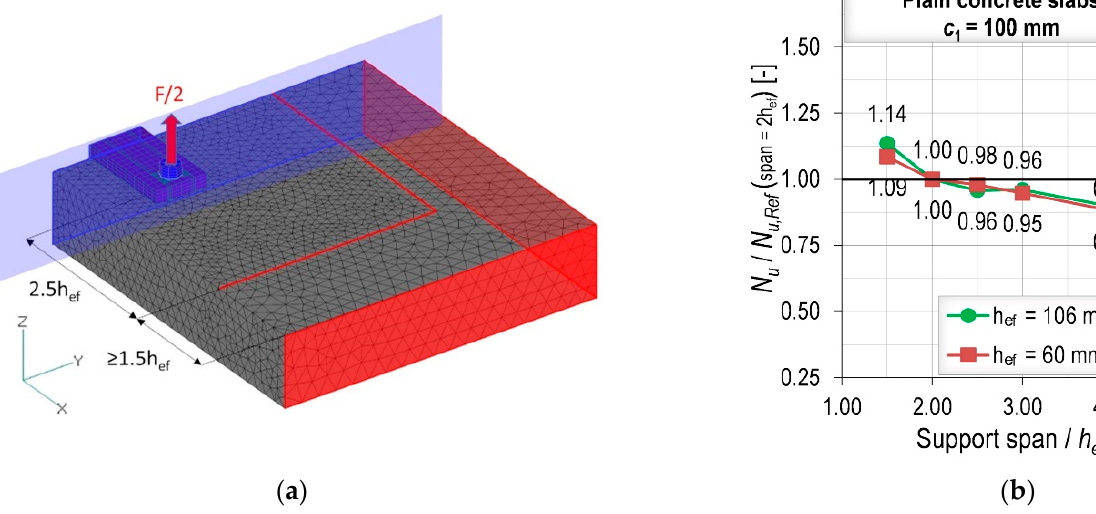
Figure 5. ( a ) FE model used in the numerical parametric study; ( b ) Influence of support span.